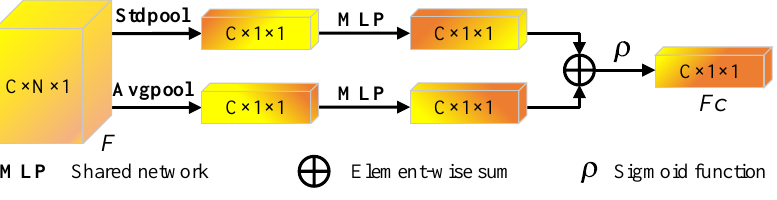
Figure 4. Channel Attention (CA) module.